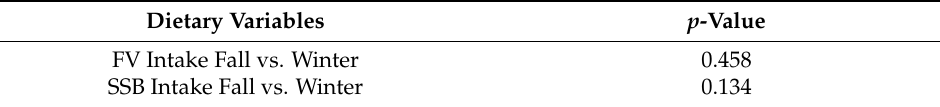
Table 3. McNemar’s test for FV and season and SSB and season.